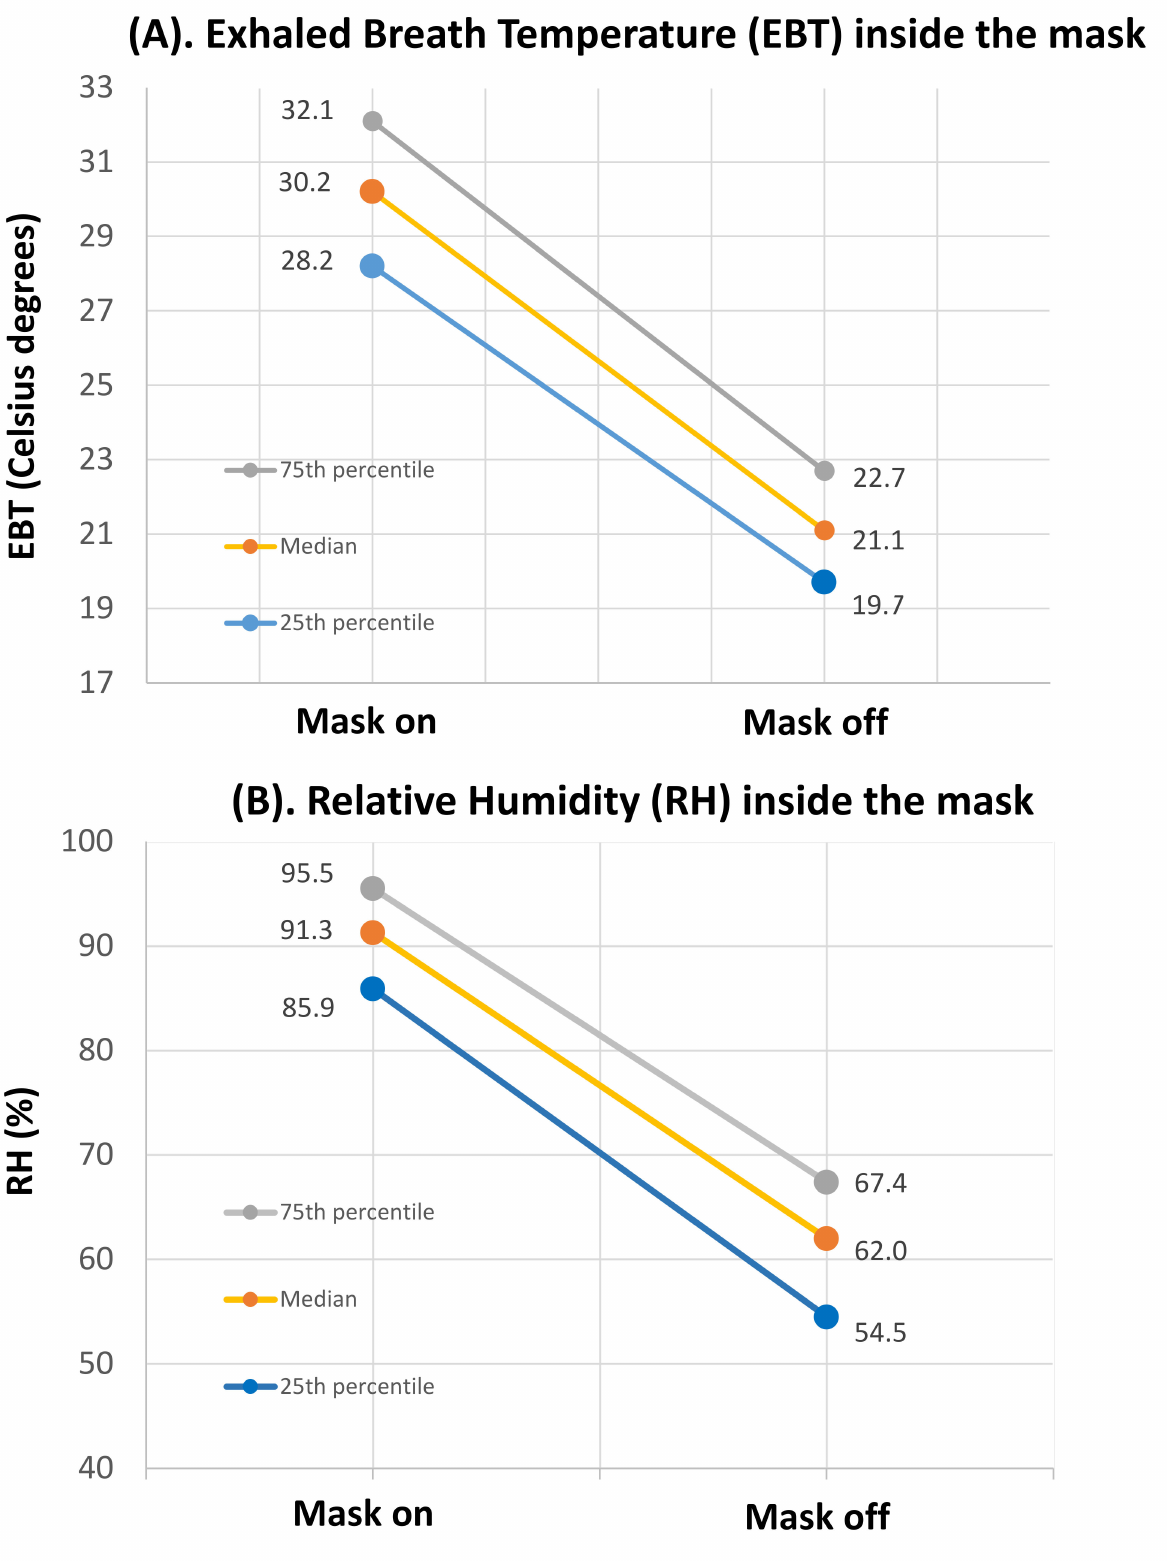
Figure 1. ( A ) From Cherrie et al. 2019 [29]. Exhaled Breath Temperature (EBT) inside the mask, measured by a sensor, when the disposable respirator (3M 9211) was worn (“Mask on”) or not (“Mask off”). Median EBT (in Celsius degrees) with interquartile range. ( B ) From Cherrie et al. 2019 [29]. Relative humidity (RH) inside the mask, measured by a sensor, when the disposable respirator (3M 9211) was worn (“Mask on”) or not (“Mask off”). Median RH (%) with interquartile